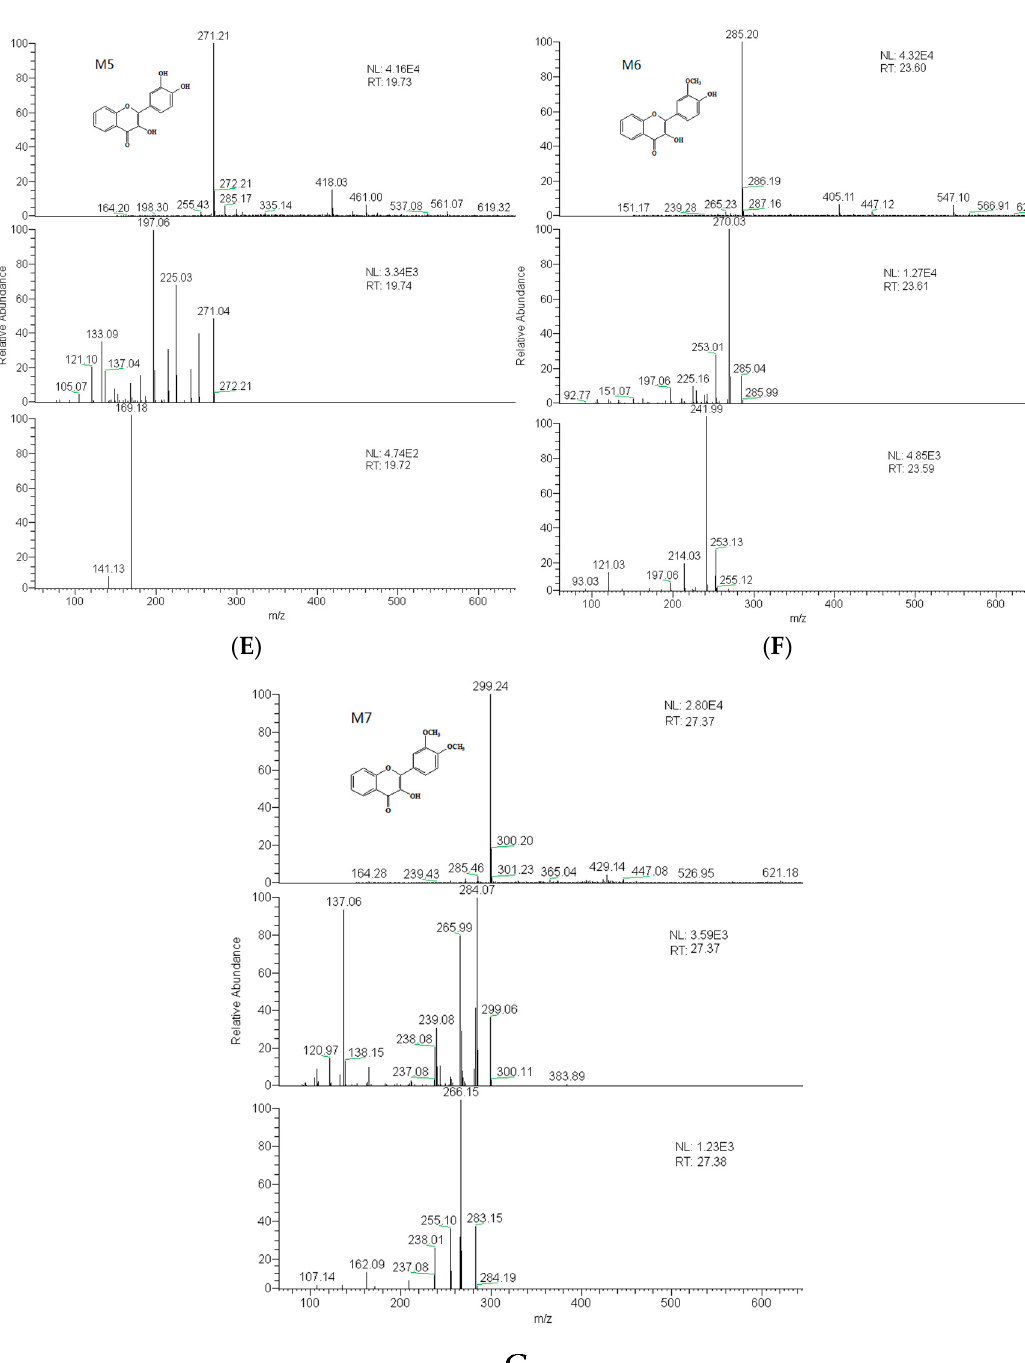
Figure 4. The mass spectra of metabolites in positive ion mode of M1 ( A ); M2 ( B ); M3 ( C ); M4 ( D ); M5( E ); M6 ( F ) and M7 ( G ).